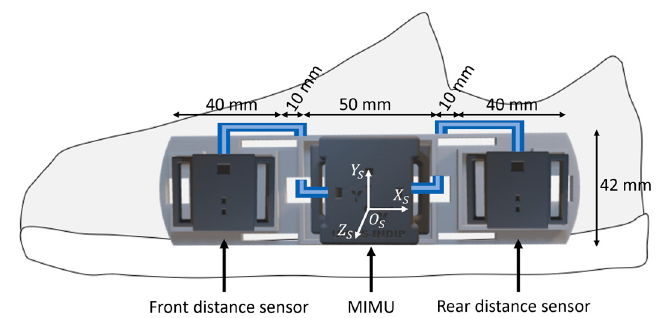
Figure 2. Wearable system: a magneto-inertial unit and two infrared time-of-flight distance sensors are cabled (in blue) and fixed to a custom 3D-printed rigid support attached to the medial side of a shoe. The size of the wearable system (sensors and rigid support) is 155 mm × 42 mm × 22 mm and the overall weight is ~40 g. The MIMU coordinate system (CS S ) is depicted in white.